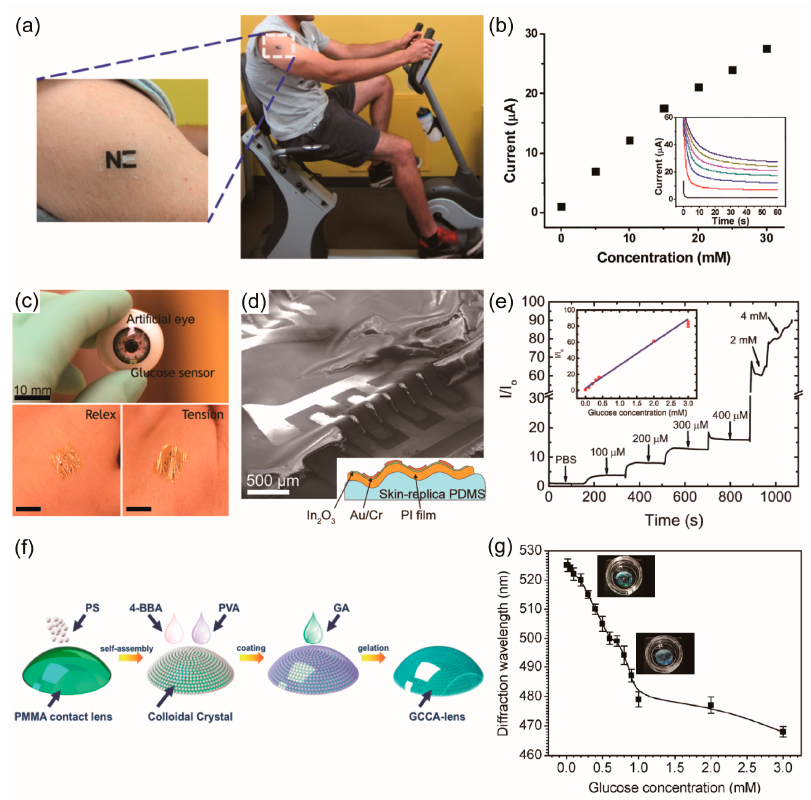
Figure 6. Wearable biosensors ( a ) The images of the temporary transfer-tattoo biosensor attached on deltoid. ( b ) Amperometric response as a function of lactate concentration for the sensor at 37 °C. Inset: profiles of current at different lactate concentrations. Reprinted with permission from [136]. Copyright 2013, American Chemical Society. ( c ) Conceptual images of conformally contacted devices on an artificial eye for glucose sensing in tears are shown. Thin-film sensors remained in contact with skin even during tension and relaxation (scale bars 10 mm). ( d ) Scanning electron microscope image of a representative device (thickness of 1.7 µ m) on an artificial PDMS skin replica indicating conformal contact between the device and the substrate (scale bar 500 µ m). ( e ) Representative responses of In2O3 sensors to physiologically relevant D -glucose concentrations found in human diabetic tears (lower range) and blood (upper range). Inset: data from five devices. Error bars represent standard deviations of the means. Reprinted with permission from Ref. [40]. Copyright 2013, American Chemical Society. ( f ) The preparation route of the 4-boronobenzaldehyde (4-BBA)-modified poly(vinyl alcohol) (PVA) gelated colloidal crystal array (GCCA)-lens. ( g ) The diffraction response at low glucose concentration. Insert: the photograph of the GCCA-lens sample. Reprinted with permission from Ref. [144]. Copyright 2017, MDPI